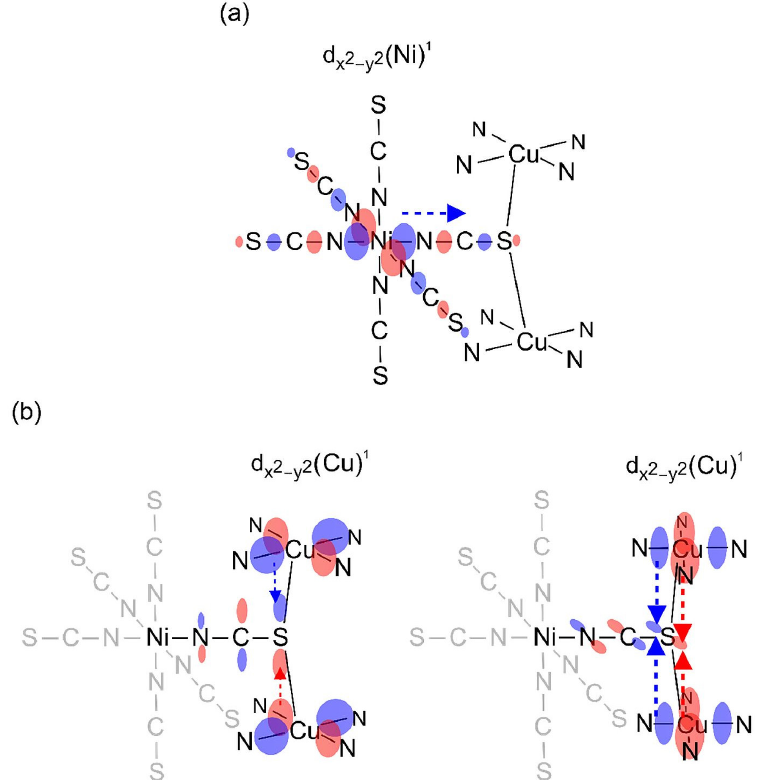
Figure 15. Schematic representation of spin density delocalization from the d x2 − y2 orbital of Ni(II) onto the σ(SCN − ) system ( a ) and from the d x2 − y2 orbital of Cu(II) onto the π(SCN − ) system ( b ) in 2 . The magnetic interaction Cu-Ni paths in 2 are similar to that of 1 depicted in Figure 12. However, due to significant overlap of natural magnetic orbitals of Cu(II) systems of end-on thiocyanato-bridged Cu(II) moieties ( d Cu-S ca . 2.36 Å)( b ), the Cu-Cu antiferromagnetic interaction prevailed in 2 , as was shown by the fit of magnetic data.